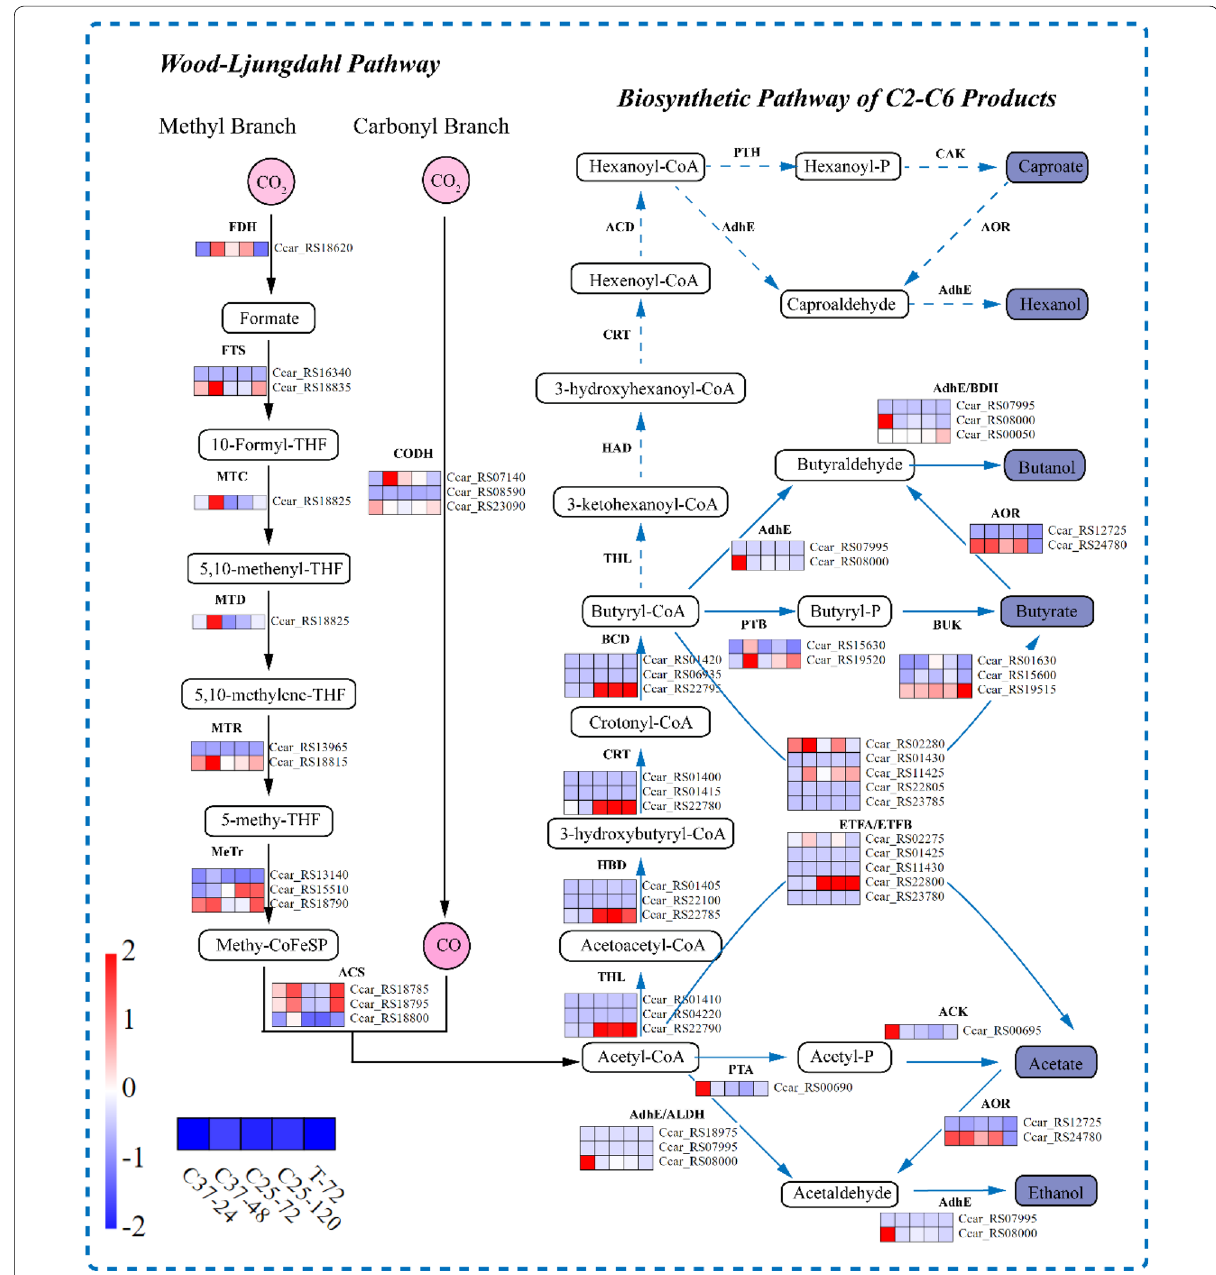
Fig. 5 Schematic diagram of the Wood–Ljungdahl pathway and C2–C6 product biosynthetic pathway in C. carboxidivorans P7. Genes’ expression level of each enzyme/protein is represented in a heat map using the FPKMs. Each box represents the transcript of one time-point in triplicate. Among the encoding genes of each enzyme/protein, the high-expressed genes are indicated in red, low-expressed ones are indicated in blue, and medium-expressed ones are indicated in white. The full annotations of the corresponding enzymes/proteins and genes are given in Additional file 2: Table S3. The end-products of C2–C6 product biosynthetic pathway are in blue boxes. The solid black arrow indicates the defined reaction of the Wood–Ljungdahl pathway; the solid blue arrow indicates the defined reaction of the C2–C4 product biosynthetic pathway; the dotted blue arrow indicates the putative reaction of the C6 product biosynthetic